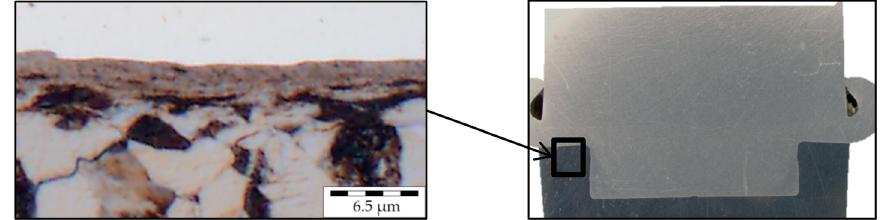
Figure 13. ( Left ) fine-grained layer on the steel side close to the joining zone and ( right ) overview of Geometry A.